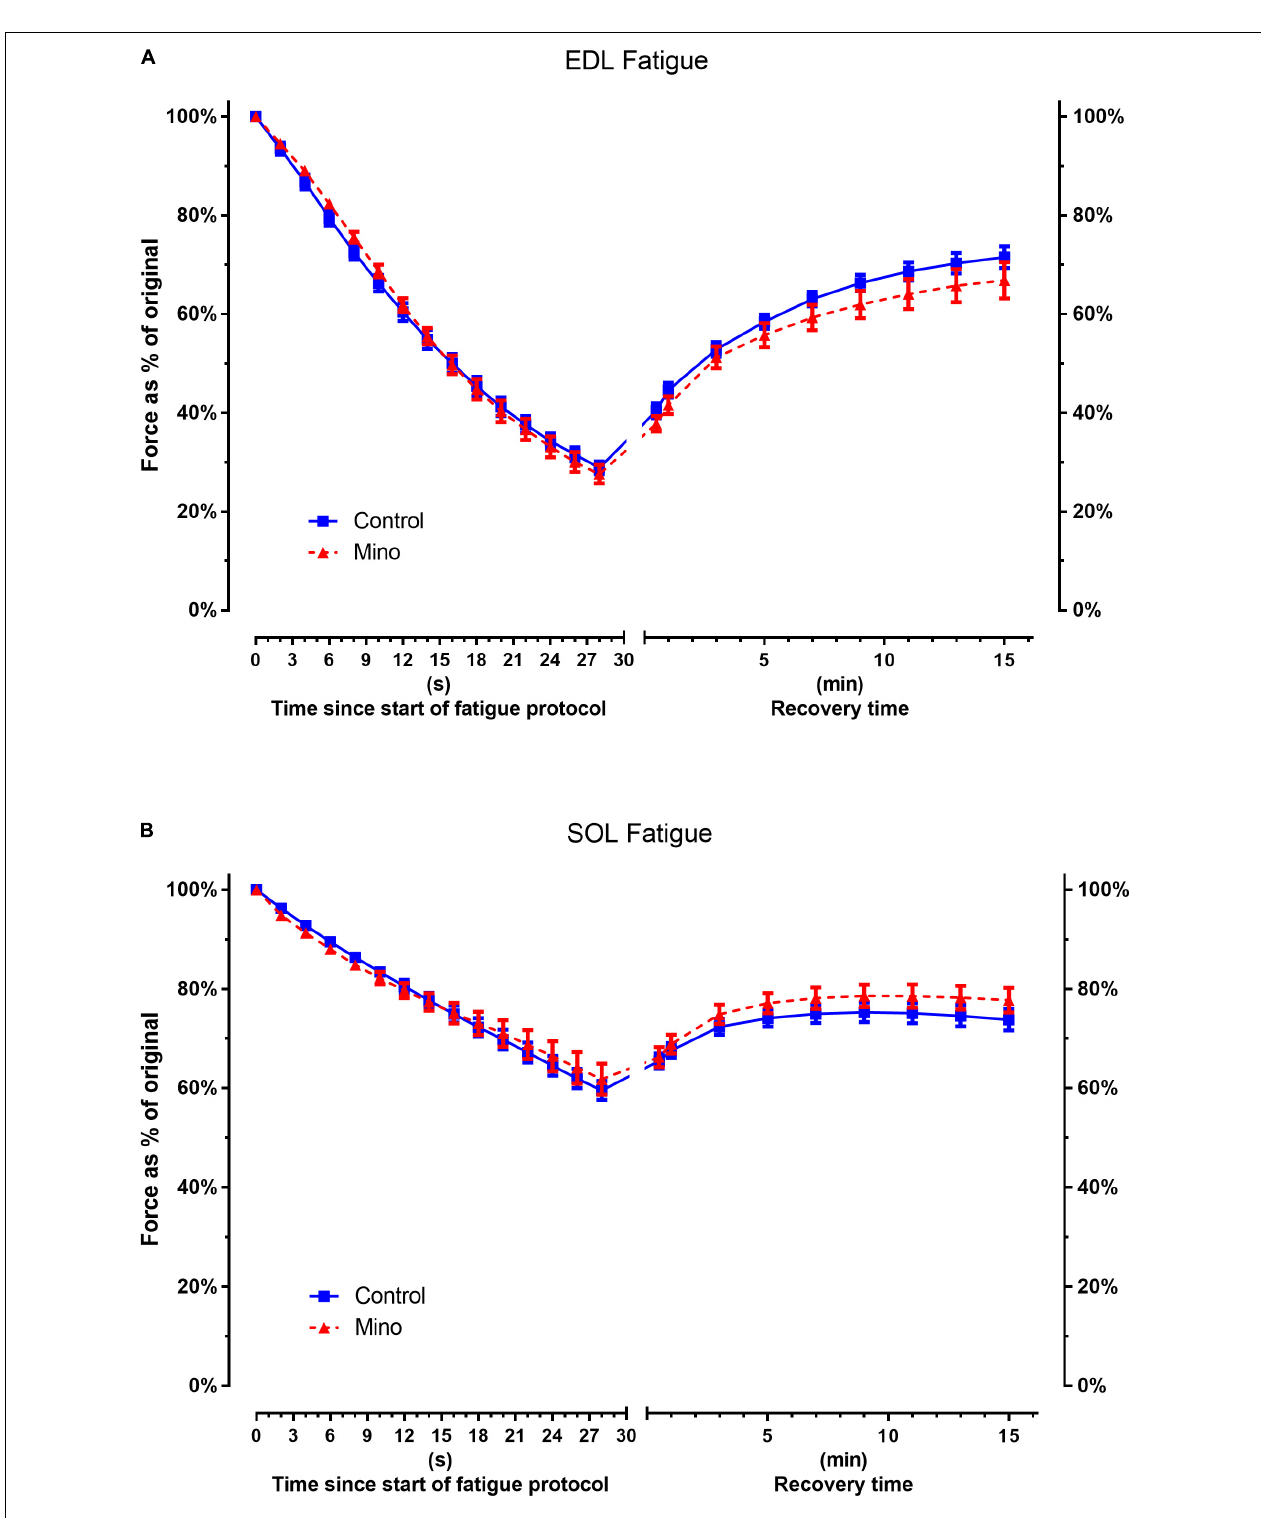
FIGURE 3 | Minocycline treatment does not alter fast-twitch EDL or slow-twitch soleus fatigability. (A) Fast-twitch EDL force decline during fatiguing stimulated contractions or force recovery is not altered with minocycline treatment. (B) Slow-twitch soleus force decline during fatiguing stimulated contractions or recovery is not altered with minocycline treatment. Statistical analysis was performed at fatigue end point t = 30 s and recovery end point t = 15 min ( Table 3 ). EDL muscle: n = 7 for Control, n = 9 for Mino. Soleus: n = 10 for Control, n = 9 for Mino. Values are mean ± SD.